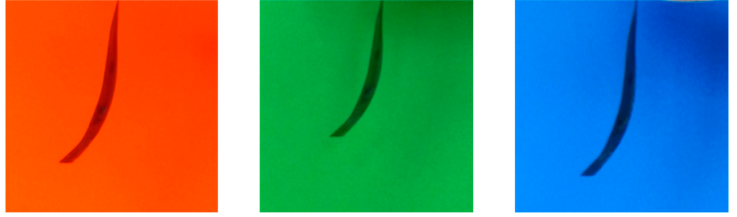
Figure 16. Several coloured backgrounds tested for good contrast with the sample.